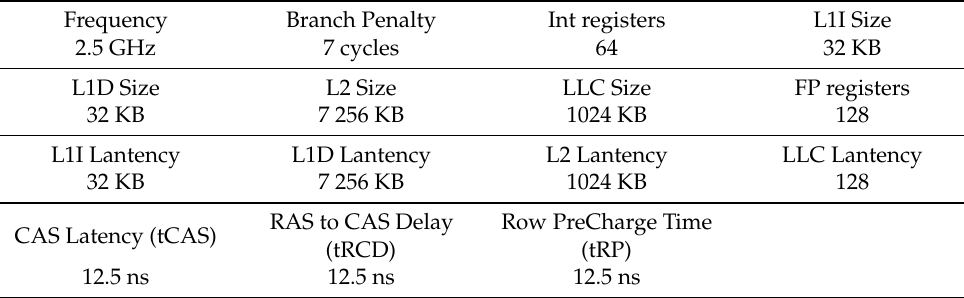
Table 3. Processor configuration and system parameters for